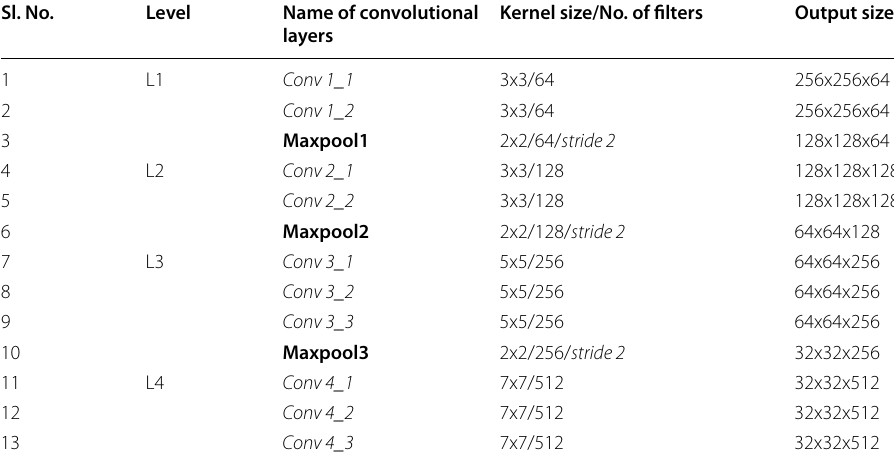
Table 1 Details of various convolutional layers in WCNN model Sl. No. Level Name of convolutional Kernel size/No. of layers